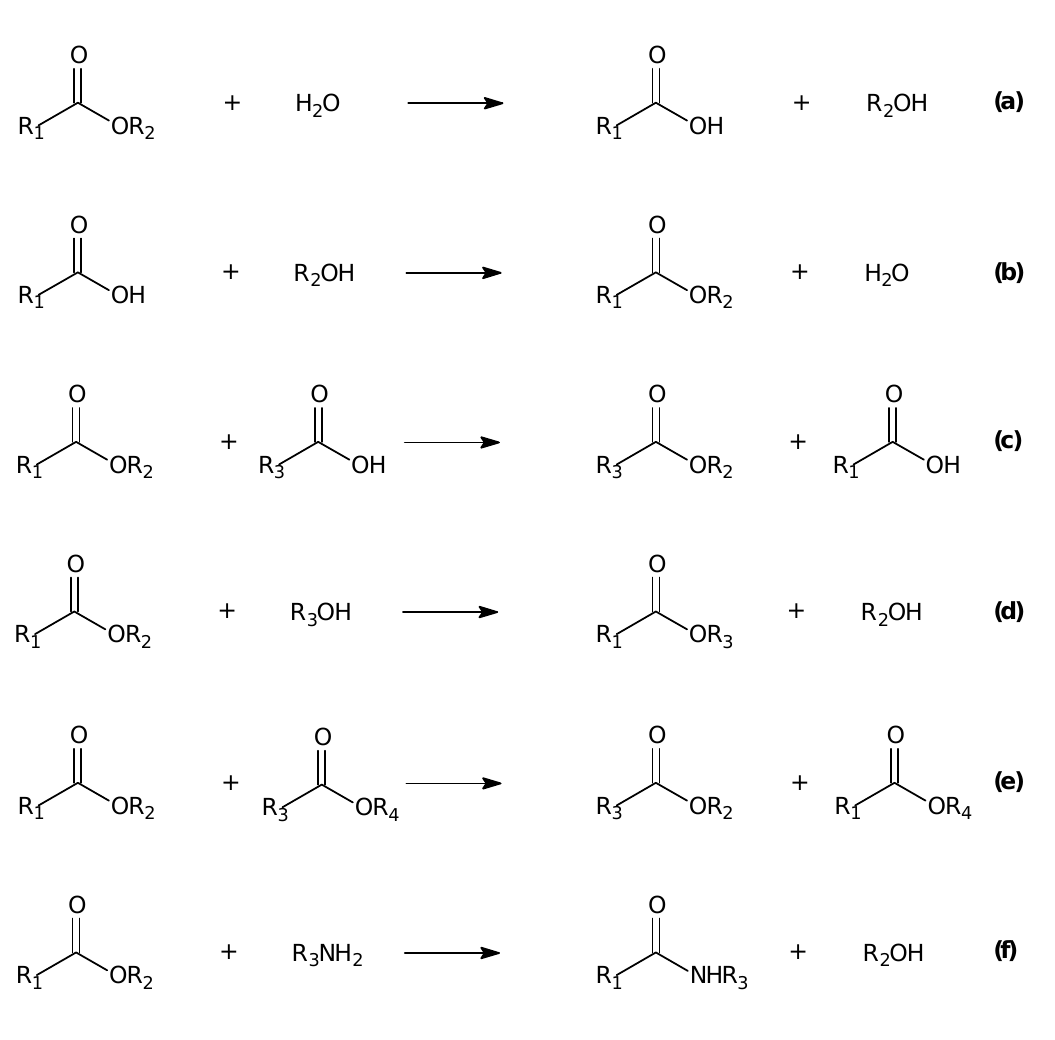
Scheme 3. Processes catalyzed by lipases: (a) enzyme-catalyzed hydrolysis, (b)